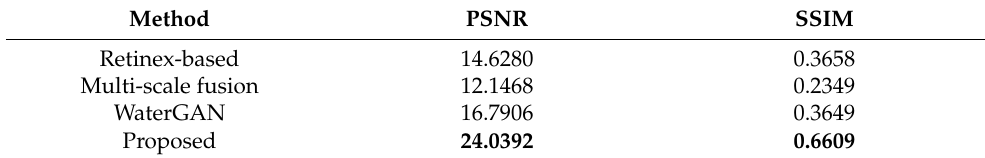
Table 2. PSNR and SSIM values between the output of different methods and the original image.